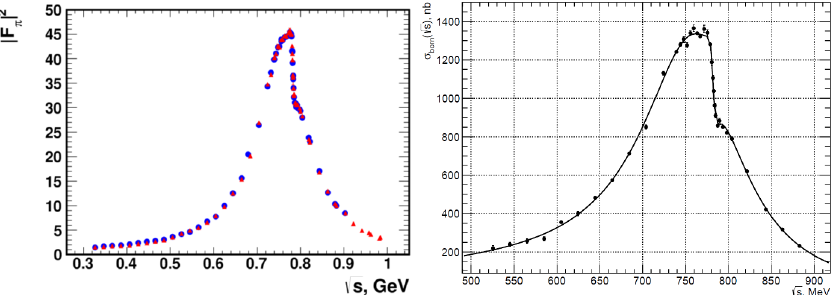
Figure 1. Left: the pion electromagnetic form factor measured by CMD-3. Tte triangles represent the result obtained using e /π separation based on calorimeter information, while the filled circles represent result based on information from the tracker. Right: The e + e − → π + π − cross section measured by SND. The solid curve is the result of the fit to the SND data with the VMD model.